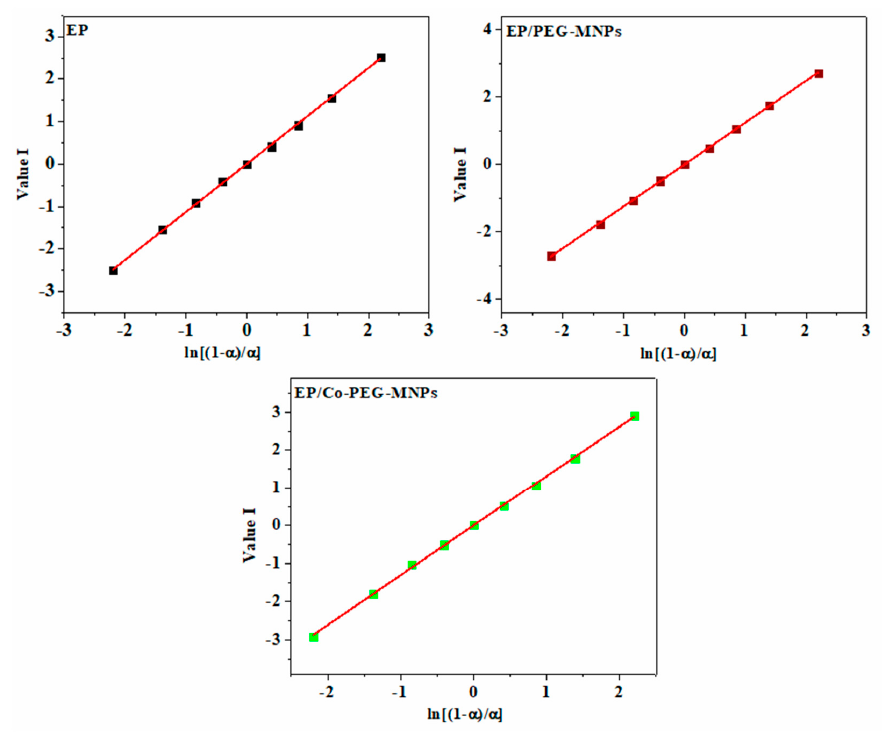
Figure A4. Variation of Value I of the samples prepared in this work at typical heating rate of 5 ◦ C · min − 1 .